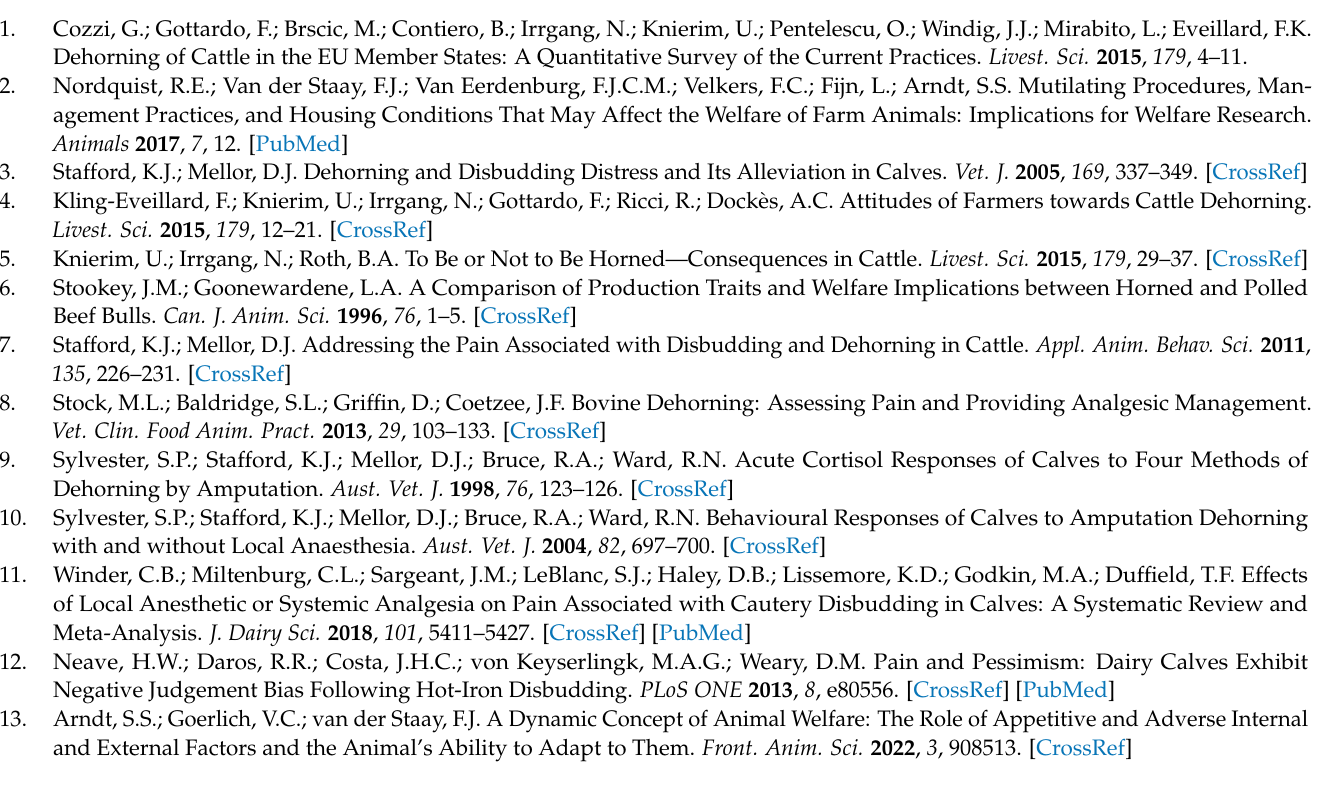
eyes; Figure S7. Thermal images of horns; Figure S8. Thermal image example of ROIs for the three studied areas eye, ear, horn; Figure S9. Thermal image example of the position of the cow to study horn temperature in rela-tion to rumination; Protocol S1: Detailed procedures for data collection and processing; Script S1: R script for data preparation; Script S2: R script for statistical analyses; Script S3: Reliability calculations; Table S2: Overview of the ICC coefficients; Table S3. Horn temperature during rumination. Raw data: Thermo Horns_Data Ruminating; Thermo Horns_environment and behaviour